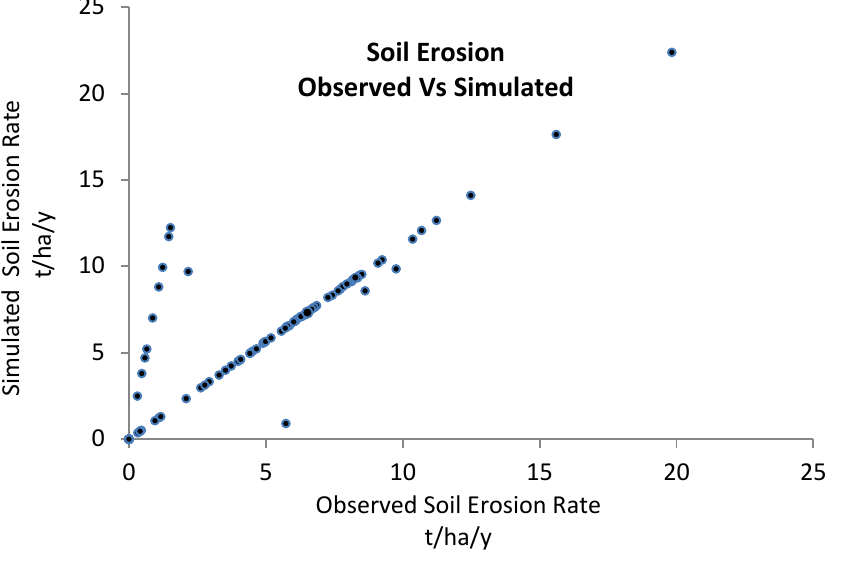
Fig. 10: Observed soil erosion rate Vs simulated soil erosion rate Table 5: Area under each class for soil erosion 2019 and projected soil erosion 2019 (areas in km 2 )